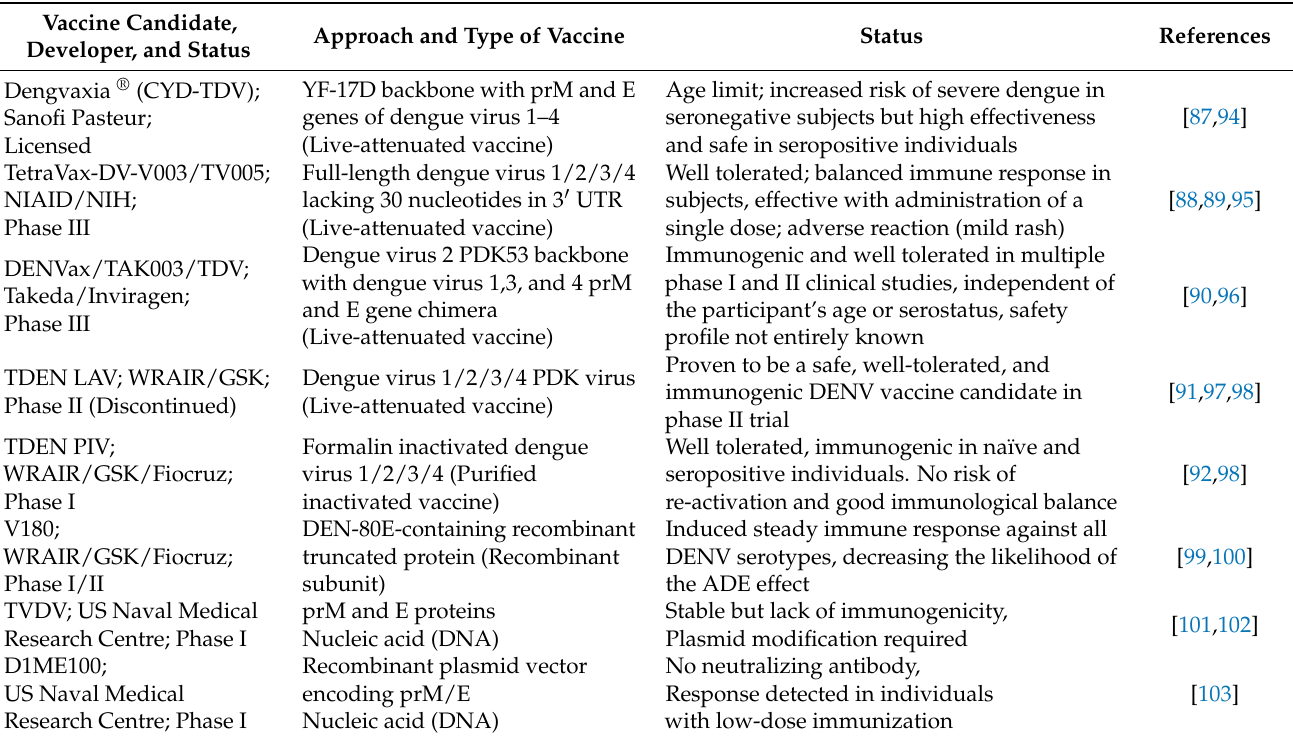
Table 2. Present status of different vaccine competitors based on live-attenuated/purified inactivated virus/recombinant subunit/nucleic acid (DNA) for